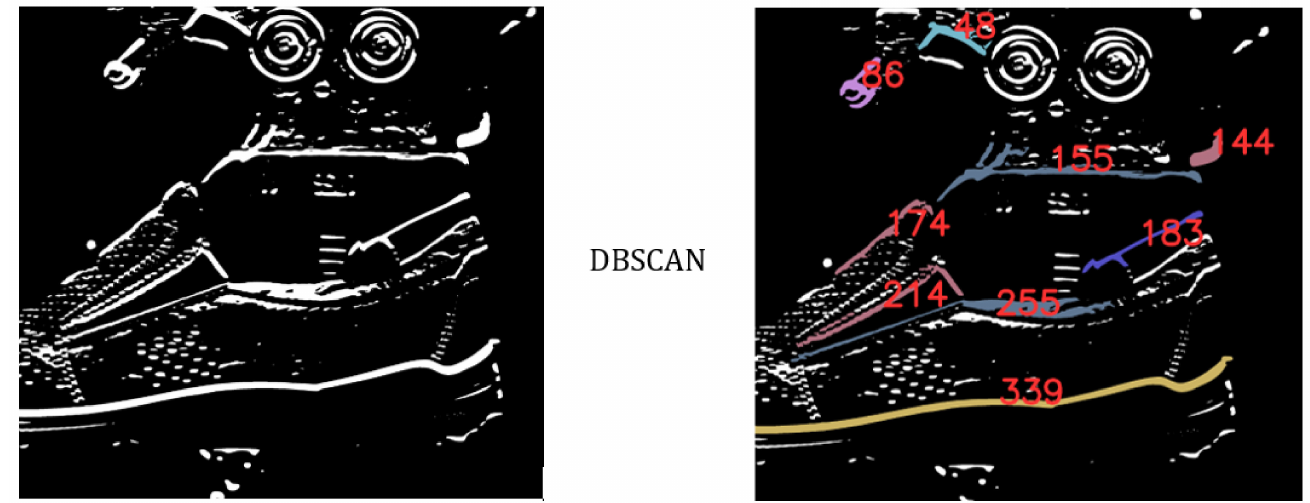
Figure 7. Implementation of the DBSCAN clustering to